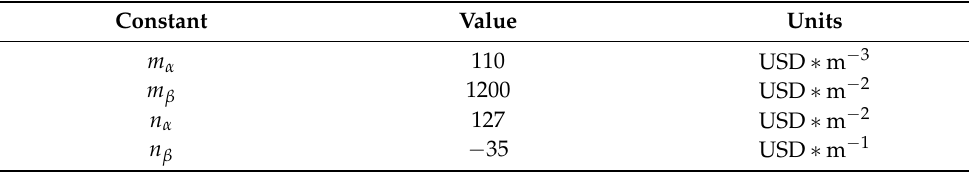
Table 2. Constants of the cost function proposed by Maurer et al.